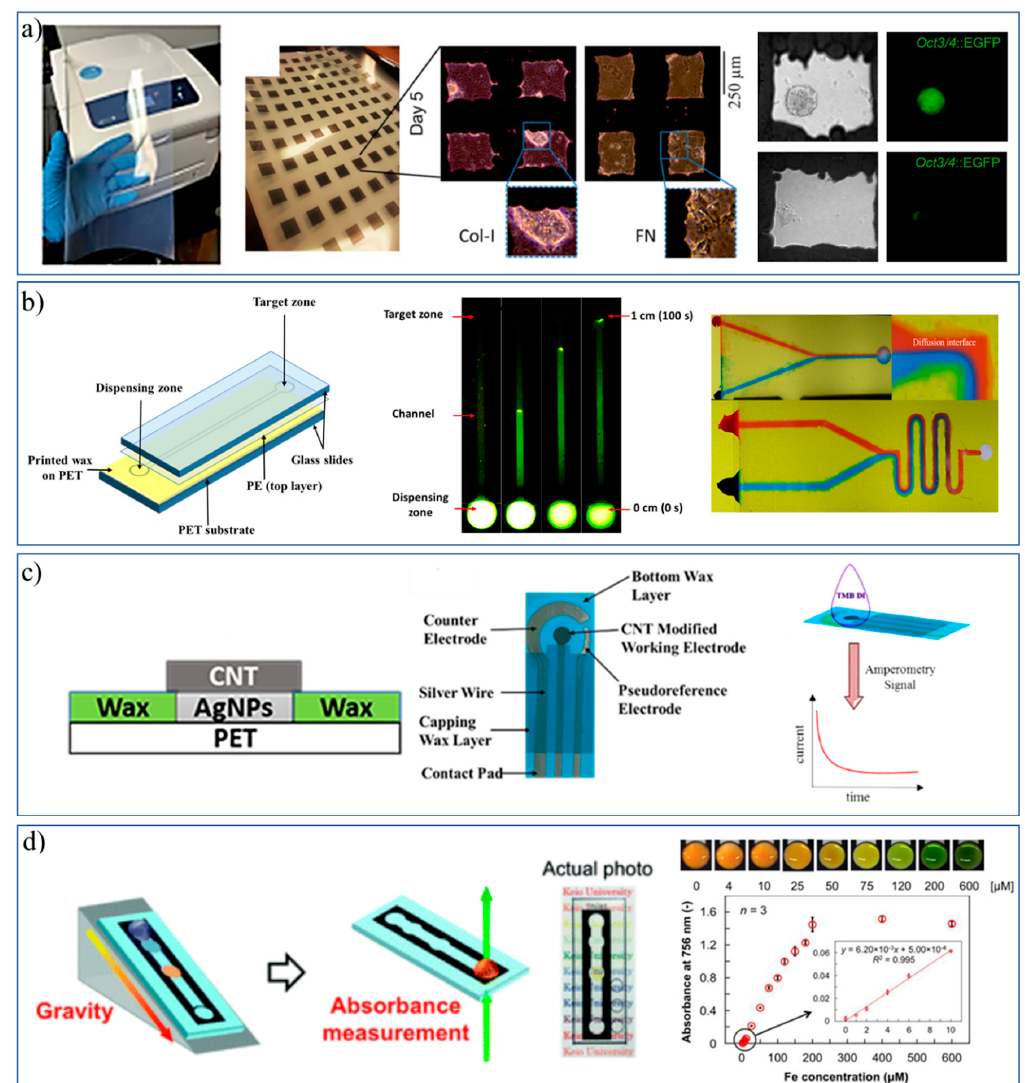
Figure 6. Wax on plastic platforms: ( a ) Wax printed microwells and stem cells applications. ( b ) Flow on fluorescently labeled DNA ( green ) and mixing of food colors ( red and blue ) in a wax ‐ on ‐ plastic microfluidic system. ( c ) Fabrication of a multilayer electrochemical sensor using a combination of wax and inkjet printing. ( d ) Device showing the gravitation flow of liquid through a wax printed channel on a transparent film for detection of Fe 2+ . (Adapted with permission from RSC and Springer Nature) [13,34–37].